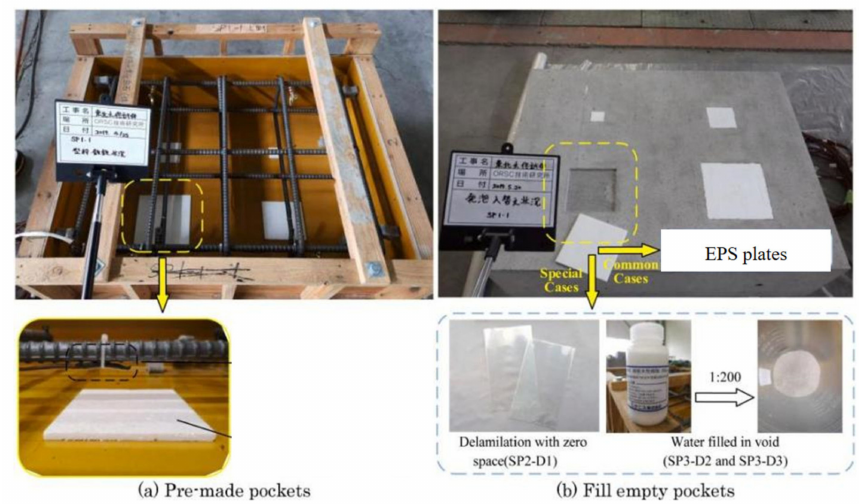
Figure 12. Methods to manufacture artificial delamination [121].